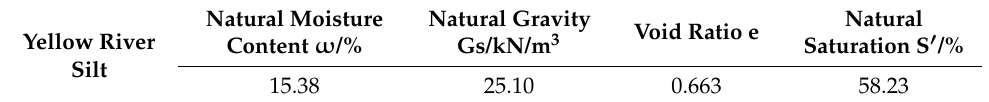
Figure 1. The map of the sampling area. Table 1. The physical parameters of the soil samples. Table 1. The physical parameters of the soil samples. Natural Gravity Natural Moisture Yellow Natural Moisture Natural Gravity Content ω/% Gs/kN/m 3 Yellow River Content ω /% River Silt Silt